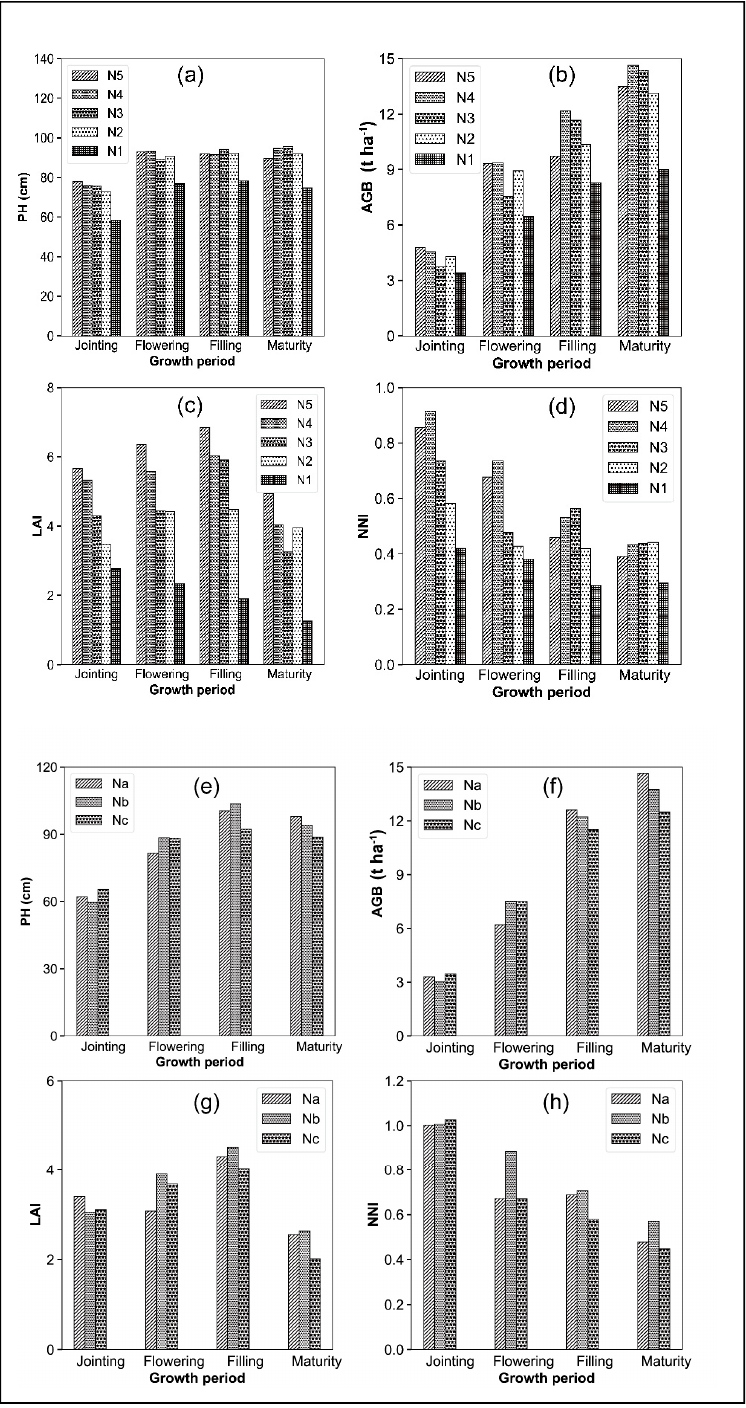
Figure 4. Histograms of rice growth variables under different nitrogen treatments at different periods: ( a , e ) PH, ( b , f ), AGB, ( c , g ) LAI, and ( d , h ) NNI in the Pukou and Luhe experiments, respectively. N5, N4, N3, N2, N1 were different nitrogen treatments in Pukou experiment and Na, Nb, Nc were different nitrogen treatments in Luhe experiment.